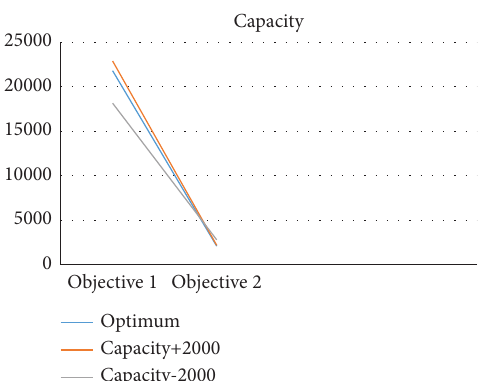
Figure 7: Capacity changing effects on both functions.